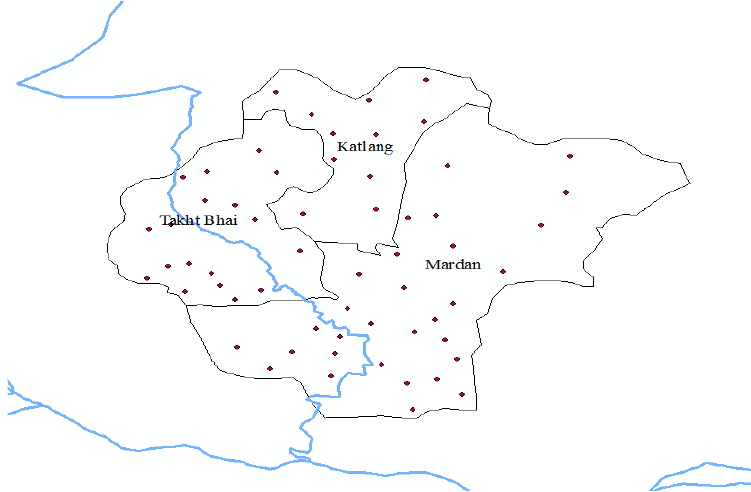
Figure 2. DOTS facilities pre-2012., Dots shows the health centers providing TB care, Blue line shows the river, and black lines are the boundaries of sub districts.